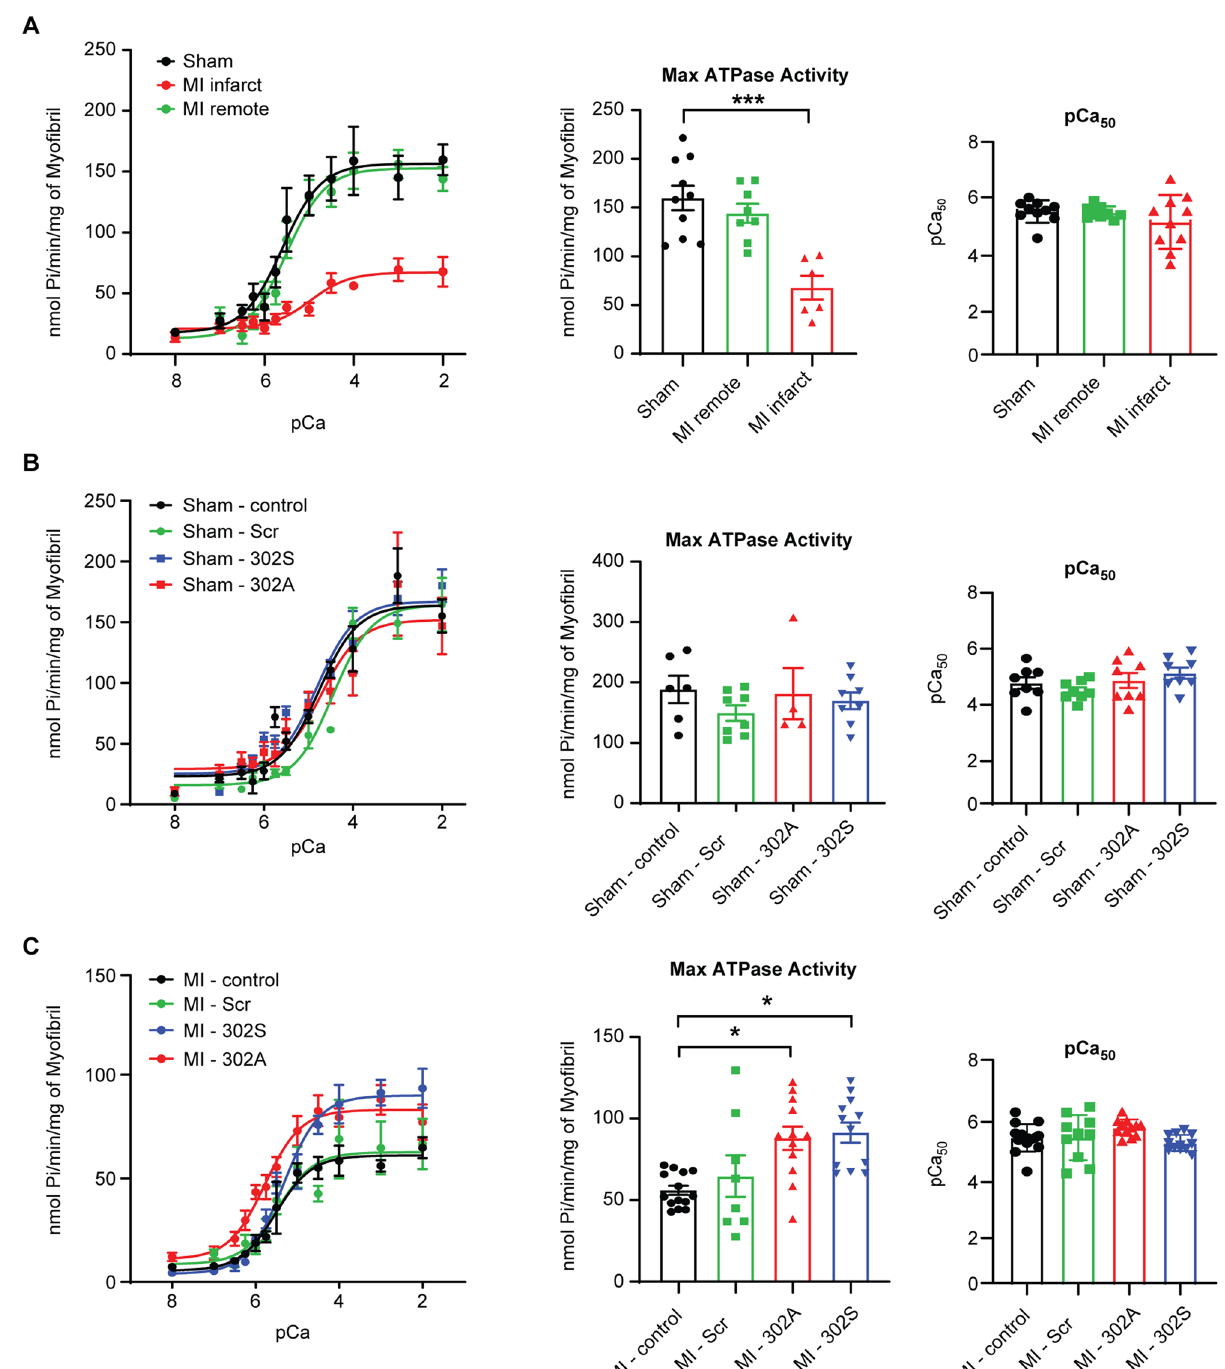
Figure 4. Myofibril ATPase activity was increased by cMyBP-C peptides 302A and 302S at week 1 in post-MI rats, but not in sham rats. ( A ) ATPase activity was reduced more than 50% in myofibrils from the MI infarct zone, but unchanged in myofibrils from the MI remote zone compared to myofibrils from sham hearts (left). Myofibril ATPase activity was normalized by myofibril protein used in the assay. The maximal ATPase activity at pCa 2.0 was plotted in the bar graph (middle). The pCa 50 was also plotted to test calcium sensitivity (right). ( B ) cMyBP-C peptides 302A and 302S did not change maximal ATPase activity in myofibrils isolated from sham rats (left and middle). No change in calcium sensitivity was noted in any of the treatment groups in sham samples (right). ( C ) cMyBP-C peptides 302A and 302S increased maximal ATPase activity in myofibrils isolated from the infarct zone of week 1 post-MI rats compared to nontreatment control and scrambled peptide-treated myofibrils (left and middle). No change was noted in calcium sensitivity in any of the treatment groups in MI samples (right). Data represent mean ± SEM (N = 8–15); * p < 0.05; *** p < 0.005; one-way ANOVA with Tukey post-test. MI, myocardial